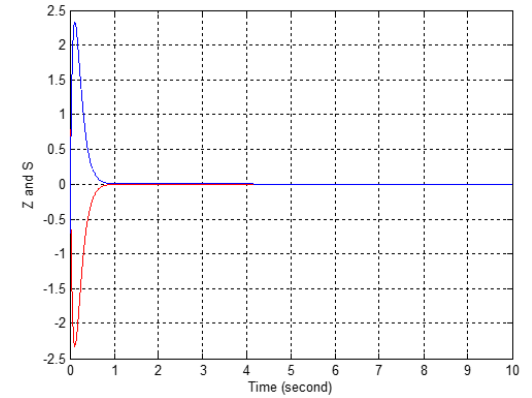
Fig. 24. The derivative error _ ISMC.